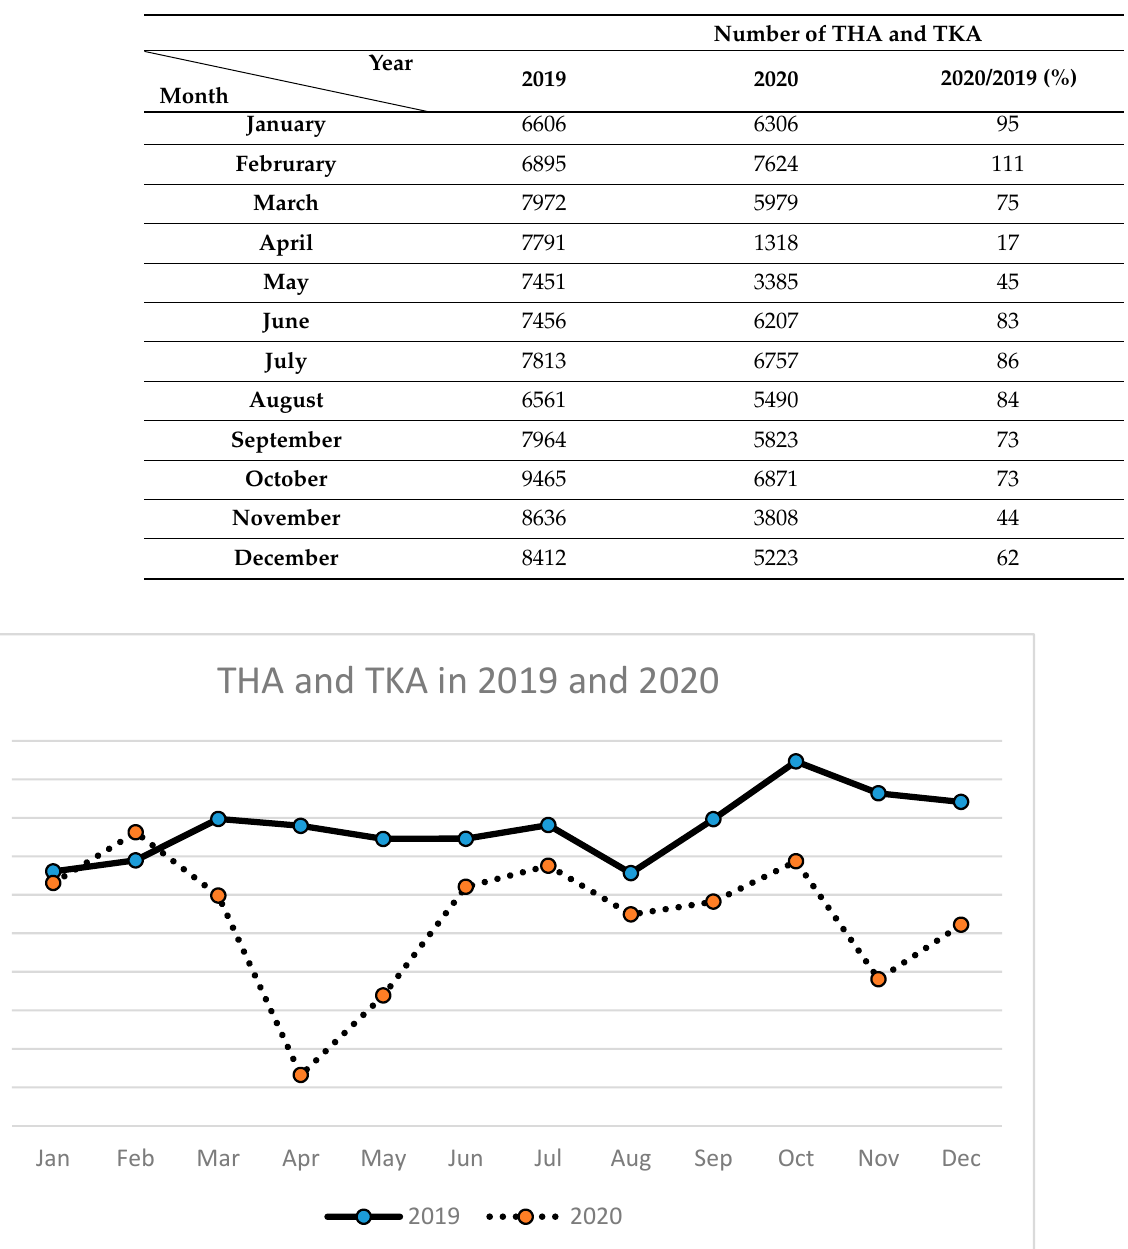
Table 2. Number of total hip arthroplasties (THA) and total knee arthroplasties (TKA) performed in the particular months of 2019 and 2020 in Poland.